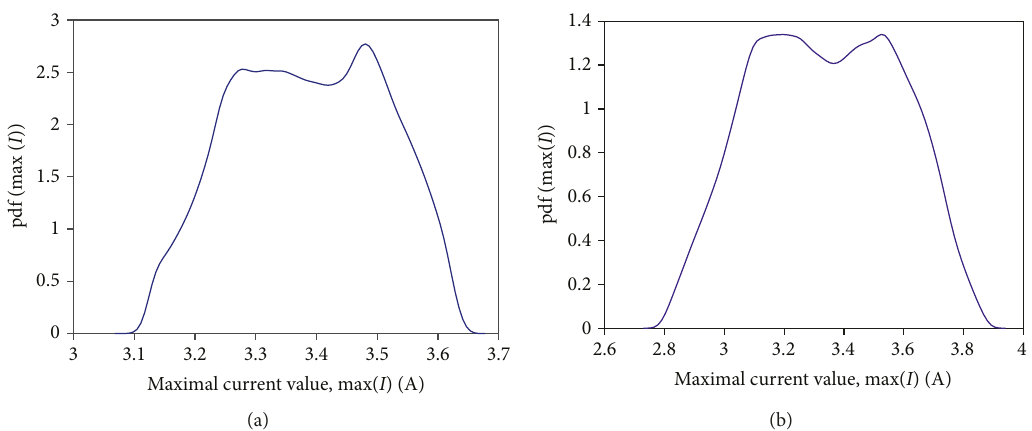
Figure 3: The probability density function of the maximal possible current value in the case of CF = 5 71 % (a) and CF = 12 % (b). The results are based on the MC sampling of the surrogate model from equation (3) with 106 samples.